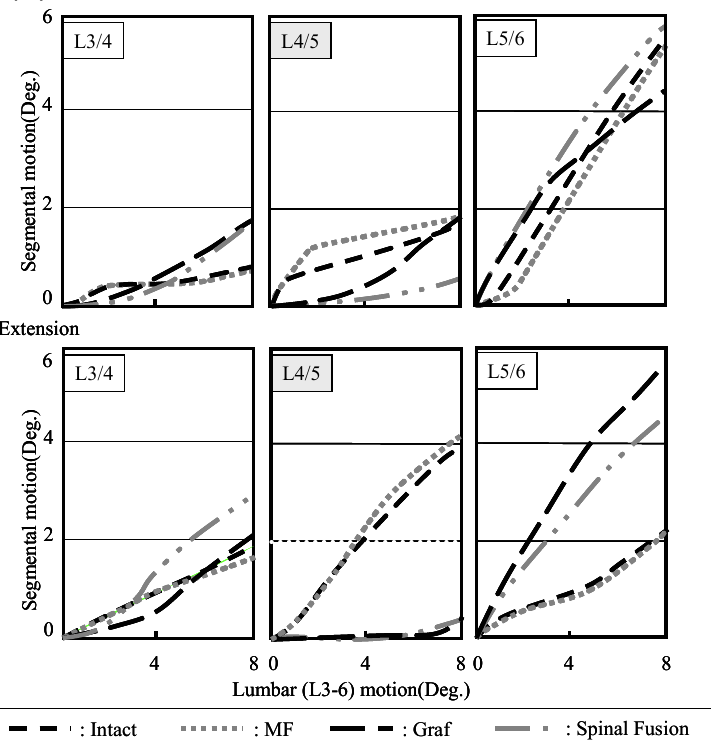
Fig. 3 Typical whole specimen motion-segmental motion curves for each instrumented model. The angular deformity of each segment increased linearly in the intact spine and MF in both positions. With the Graf system, the angular deformity of L4/5 was suppressed until 4° of deformation, and then gradually increased after 4° of deformation, ultimately equaling that of the intact